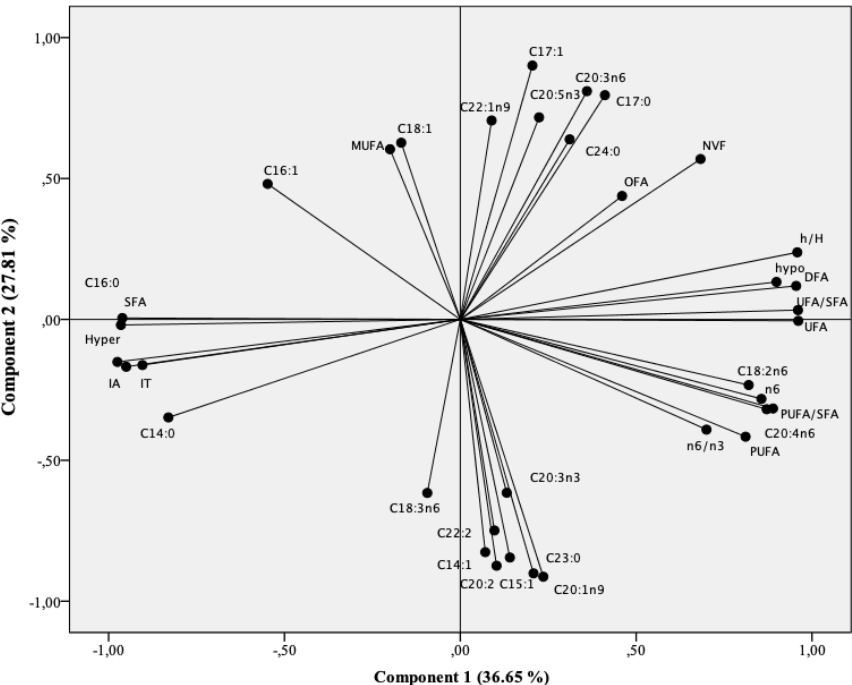
Figure 1. Projection of fatty acids and health lipid indices of intramuscular fat in the plane defined by two principal components.